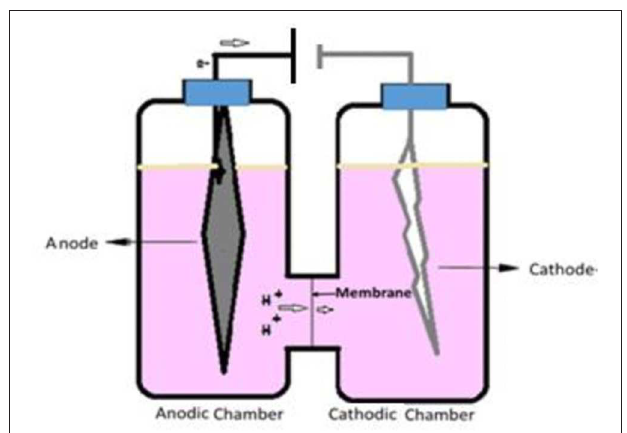
FIGURE 1 | The electrochemical cell (ECC): The ECC was assembled using the Pyrex glass fuel cell assembly as shown in the figure, separated by a nafion membrane using a leak-proof rubber gasket. The electrodes were inserted through small openings in each of the chamber caps and then connected to a power pack to supply external